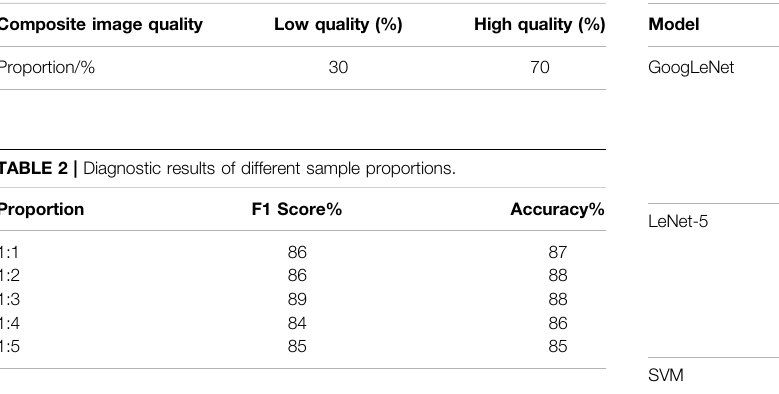
TABLE 3 | Model training